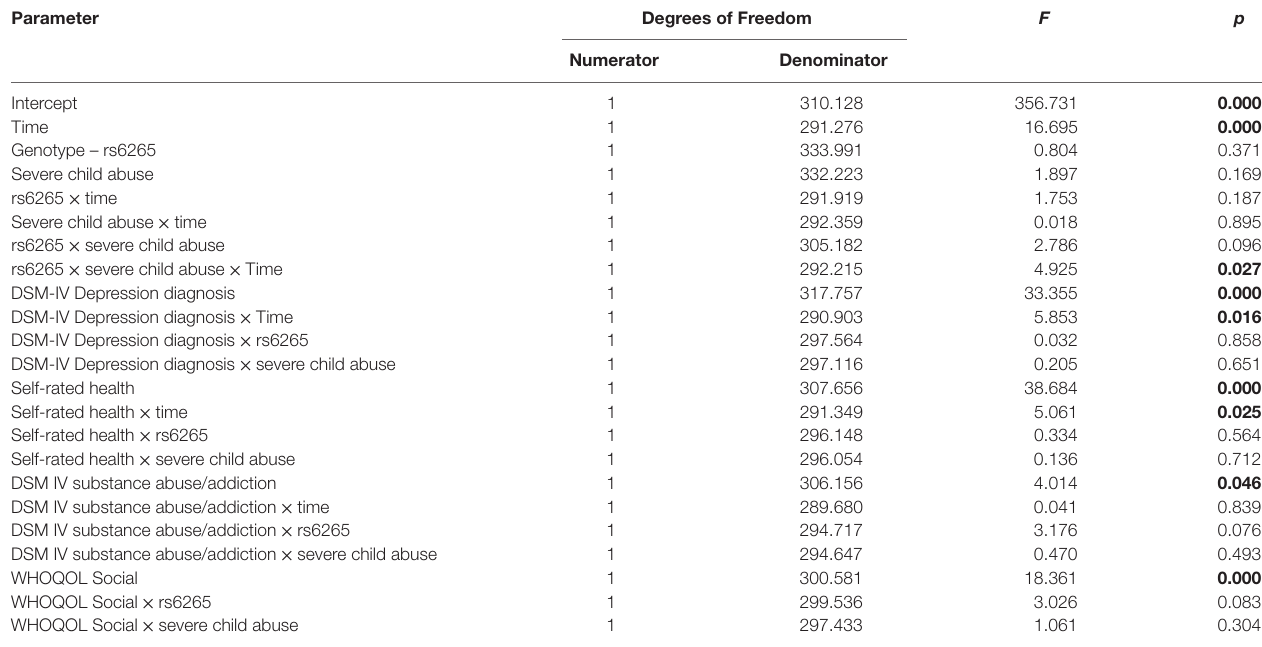
TaBle 3 | Type iii fixed effects a for terms included in the final covariate-adjusted linear mixed model.